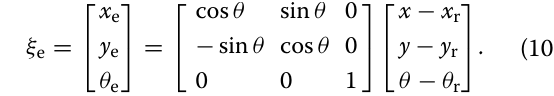
Figure 6 Membership function graphs of input/output variables